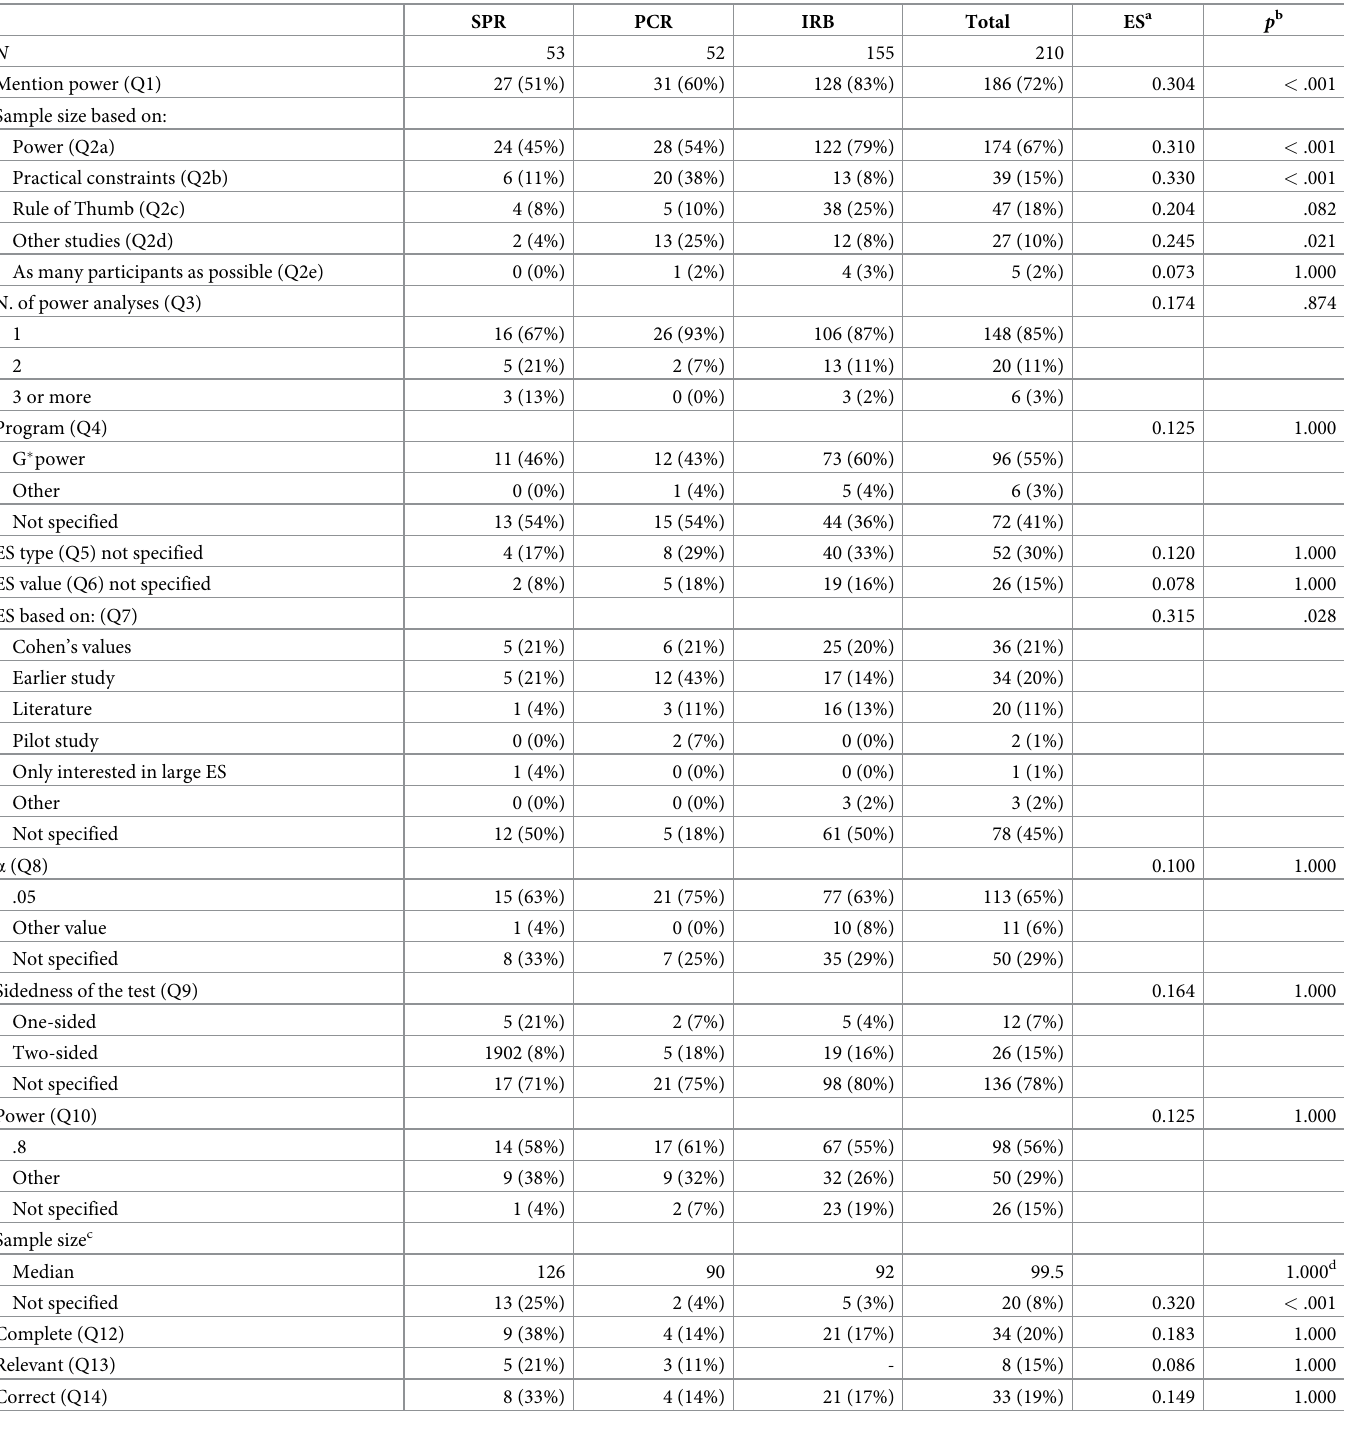
Table 1. Descriptives of all the items in the protocol for each of the registration types